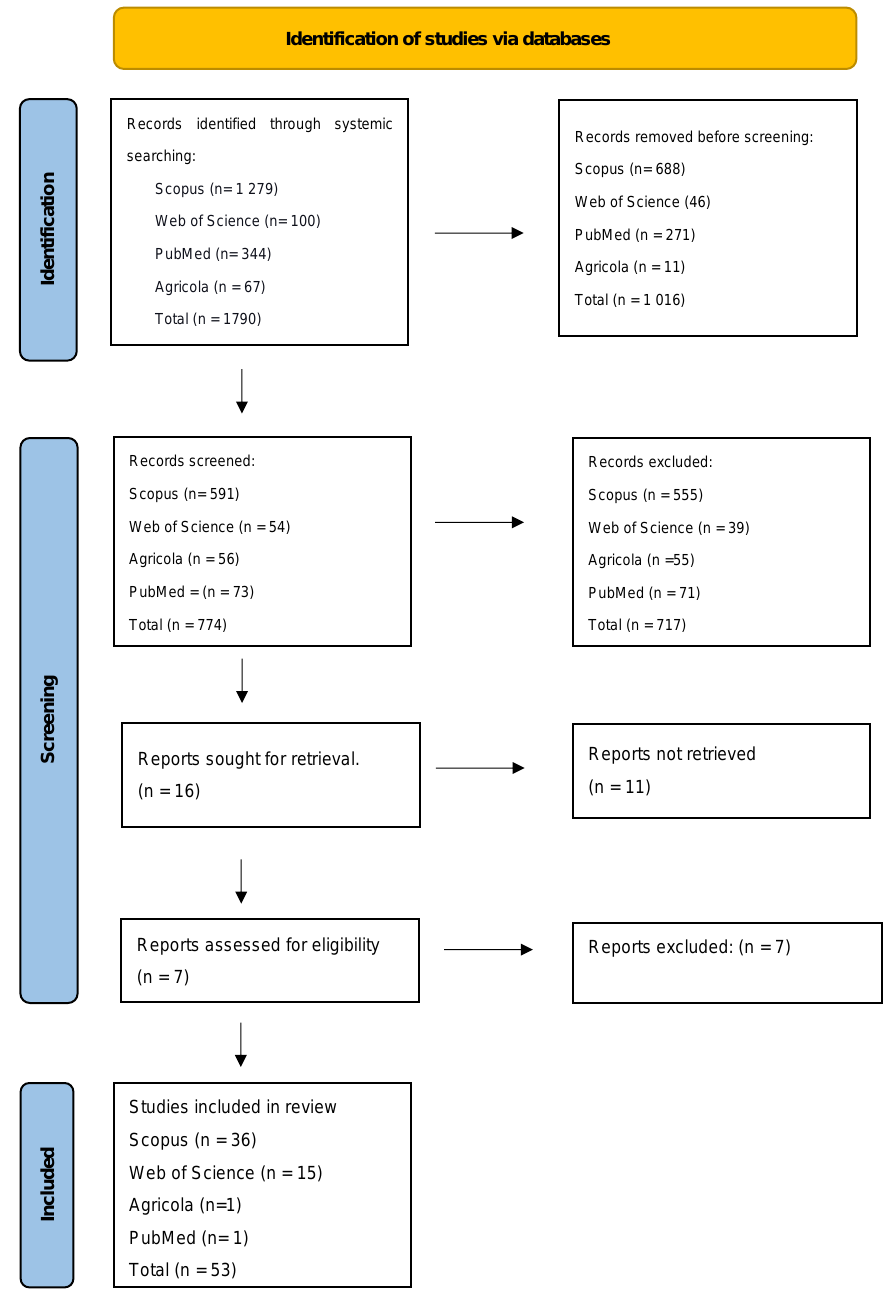
Figure 1. PRISMA 2020 flow diagram for SLR (included searches of databases